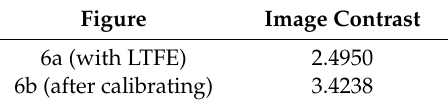
Table 5. Image contrast of Figure 6.